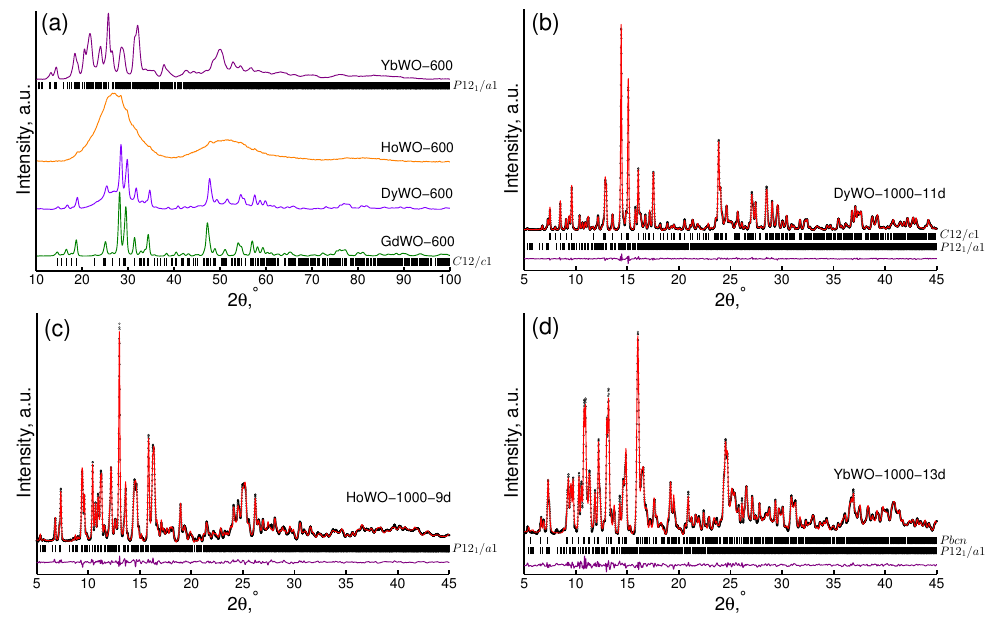
Figure 3. XRD patterns of Ln WO-600-6d (Cu K α ) ( a ) and s-XRD patterns ( λ = 0.8 Å) of DyWO-1000- 11d ( b ), HoWO-1000-9d ( c ), YbWO-1000-13d ( d ). All hydrated heavy Ln tungstates ( Ln = Dy, Ho, Yb) powders are characterized by the monoclinic structure (sp. gr. P 12 1 / a 1(14)) similar to that identified and studied in detail for In 2 (WO 4 ) 3 [44]. However, this conclusion contradicts to other literature data claiming that trihydrated form of heavy Ln tungstates Ln 2 (WO 4 ) 3 · 3H 2 O has either orthorhombic [9] or monoclinic structure (sp. gr. P 2/ m ) [8,22,23]. It is worth noting that the cell parameters